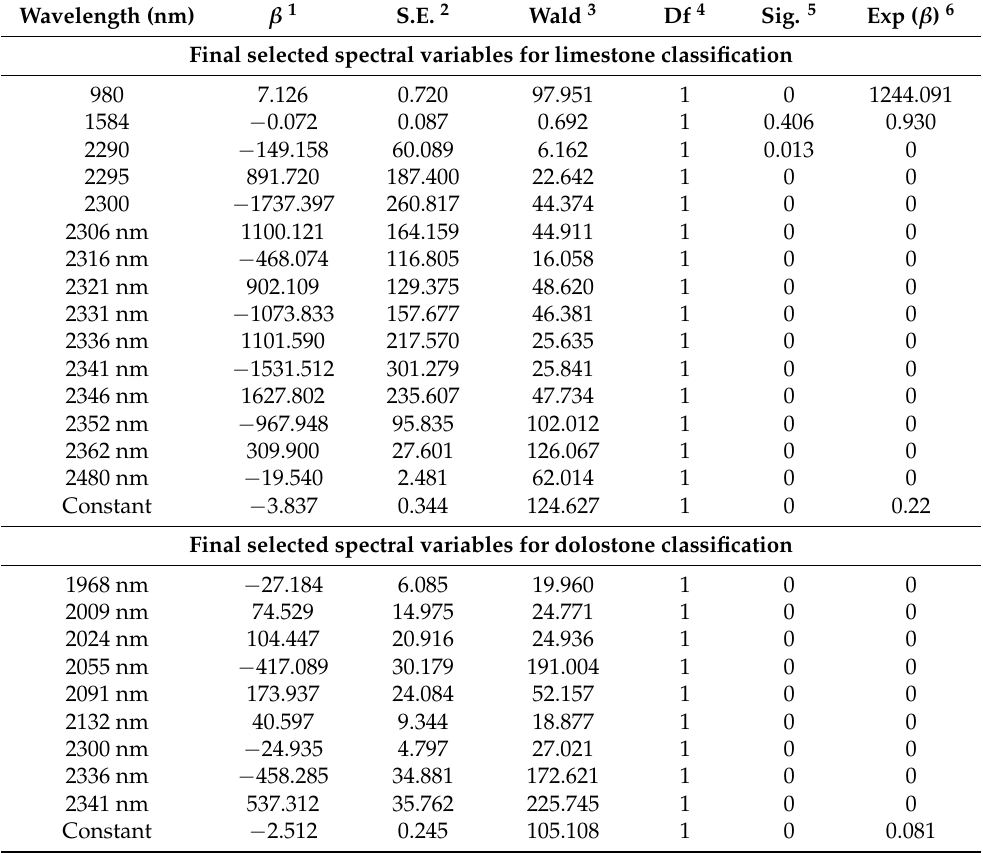
Table 3. Selected wavelength for carbonate rock indices derived from BLR and Wald test results.